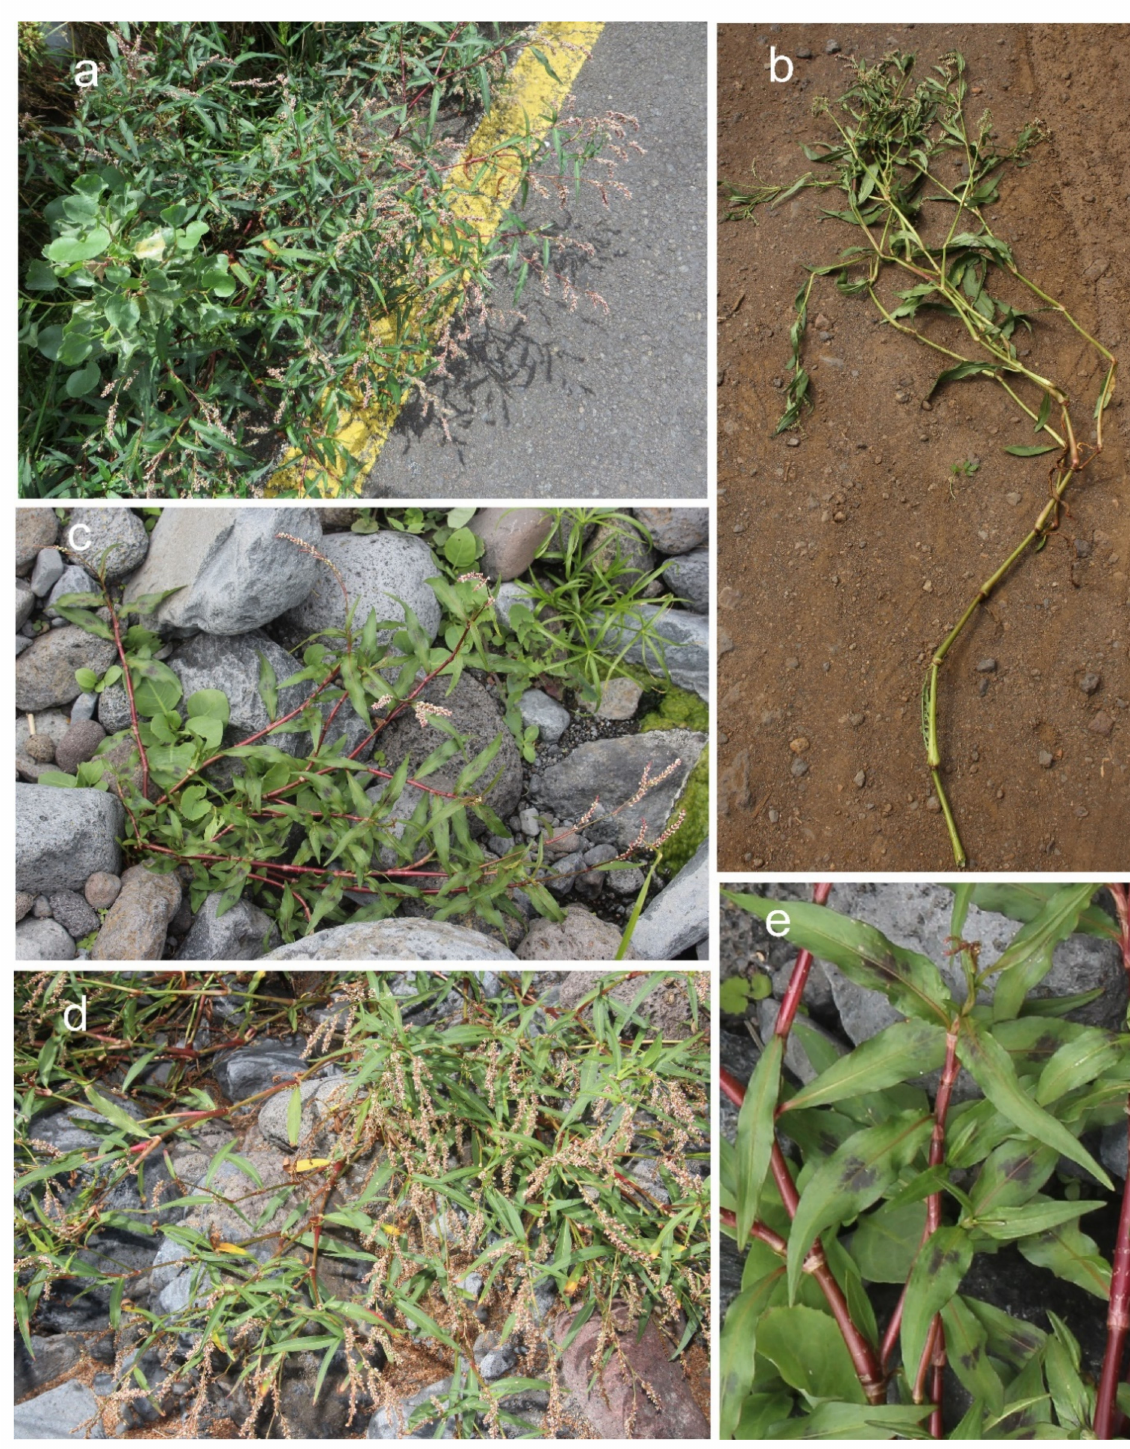
Figure 5. Persicaria hydropiperoides in La Palma: ( a ) in dense semiaquatic, disturbed vegetation in a moist concreted road trench, Los Sauces, August 2014; ( b ) a stem of such a plant parted from the rhizome neck reaches a length of more than 2.50 m, Los Sauces, September 2013; ( c ) a young specimen in the moist riverbed of the Barranco del Agua in spring, ( d ) the same location as in ( c ) but five months later, P. hydropiperoides in the almost dried-out riverbed, procumbent and semi-erect, richly fruiting, October 2013; ( e ) detail of leaf spots (these spots and the intensely purple-red colored stems are typical for sun-exposed plants or parts of plants), May 2013 (Photographs: R.